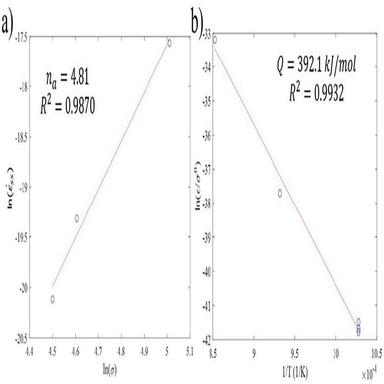
a) Natural log of ε˙ ss vs. Natural log σ to obtain the apparent creep stress exponent and b) Natural Log of ε˙ ss σ vs. 1 Tto obtain activation energy for creep.